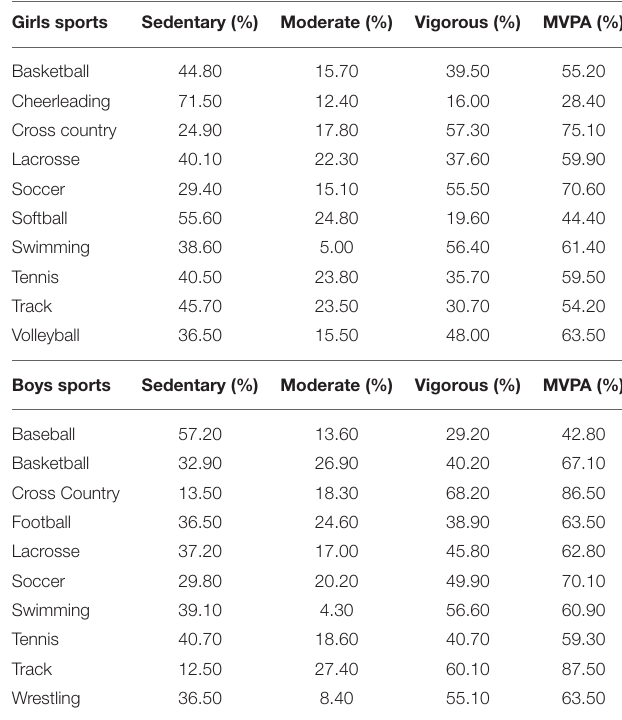
TABLE 3 | Percent of practice time that athletes engaged in sedentary, moderate and vigorous physical activity.